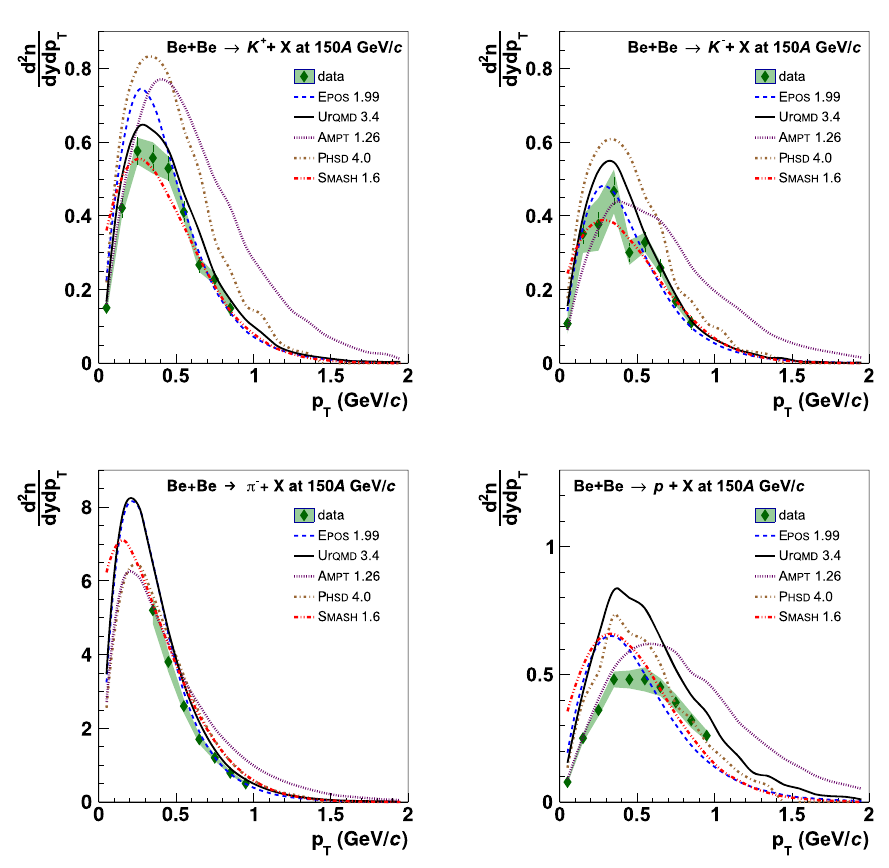
Fig. 34 Comparisonofthe p T spectraof K + (top-left), K − (top-right), π − (bottom-left) and p (bottom-right) at mid-rapidity for the 20% most central Be+Be collisions at 150 A GeV / c with models: Epos 1.99 (blue